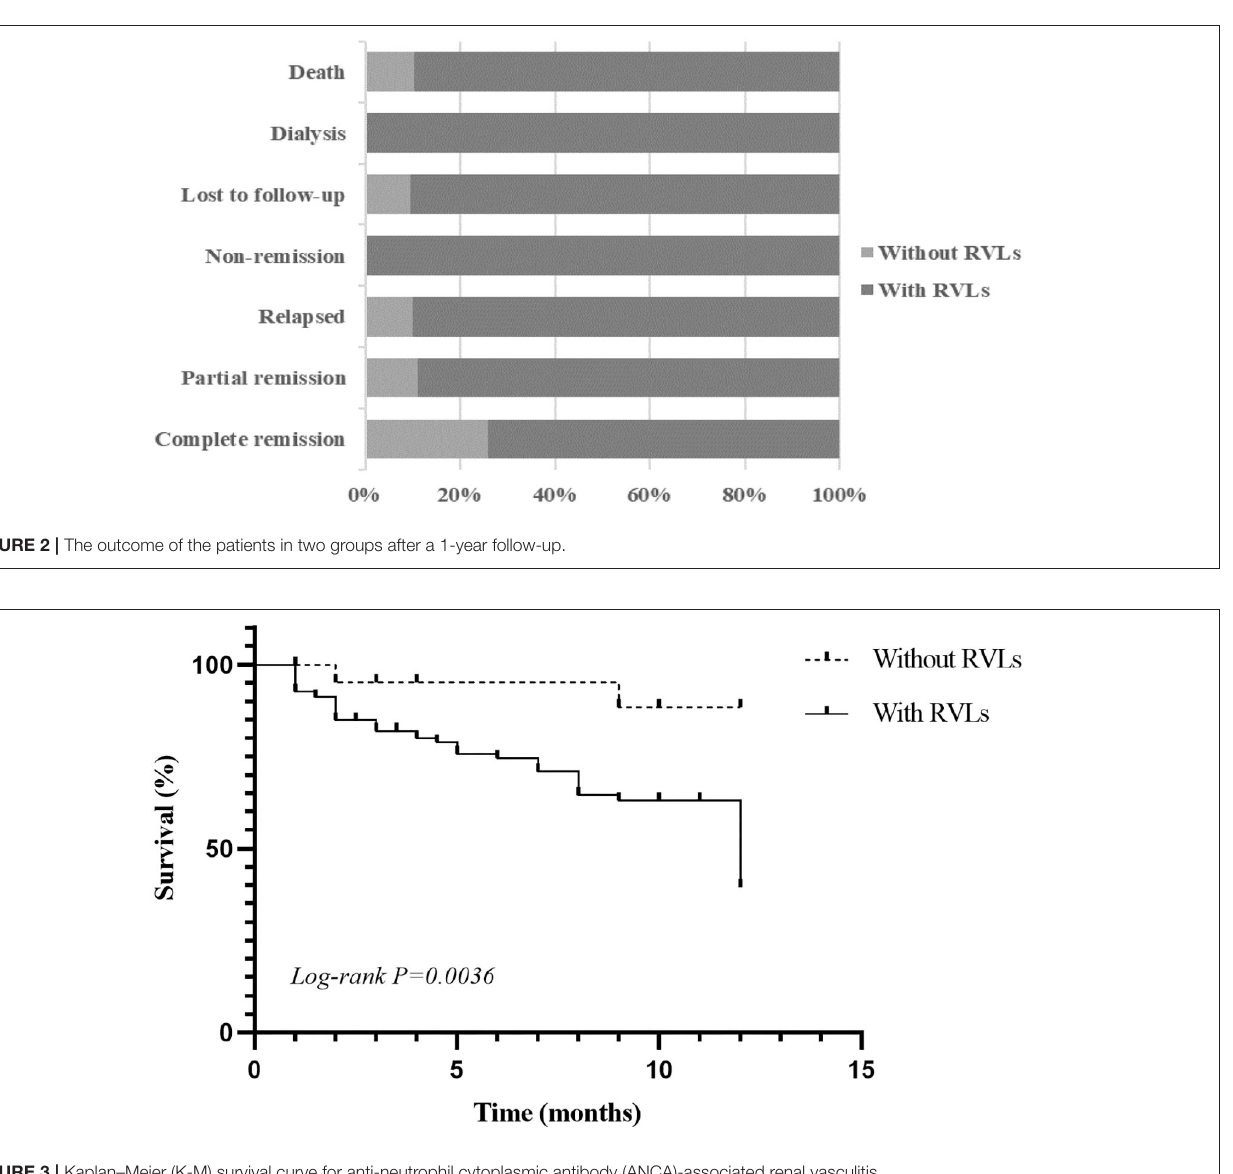
FIGURE 3 | Kaplan–Meier (K-M) survival curve for anti-neutrophil cytoplasmic antibody (ANCA)-associated renal